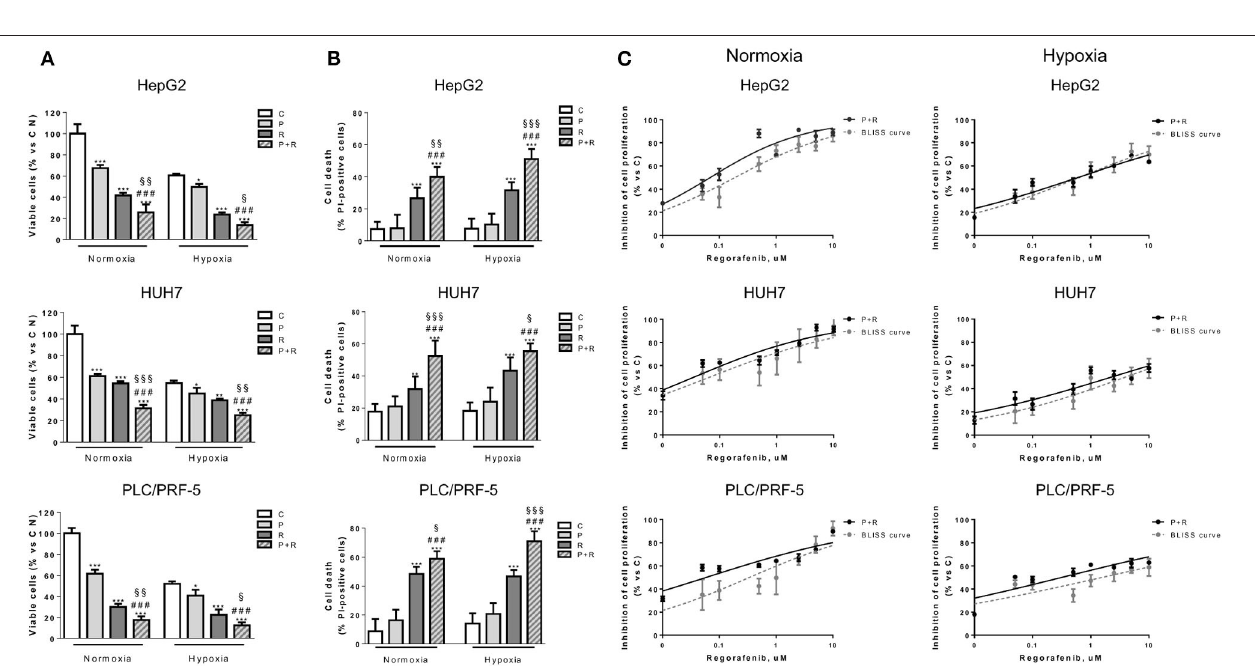
FIGURE 2 | 18h. Migrated or invaded cells were then counted. Data are expressed as percent vs. control. Representative fields of migration or invasion are shown (magnification of 100 × ). * p < 0.05, ** p < 0.01, *** p < 0.001 vs. C, # p < 0.05, ### p < 0.001 vs. P; § p < 0.05, §§ p < 0.01 vs. R. Data in panel (A) are mean values ± SD of three independent experiments. Data in panels (B,C) are representative of two independent experiments.